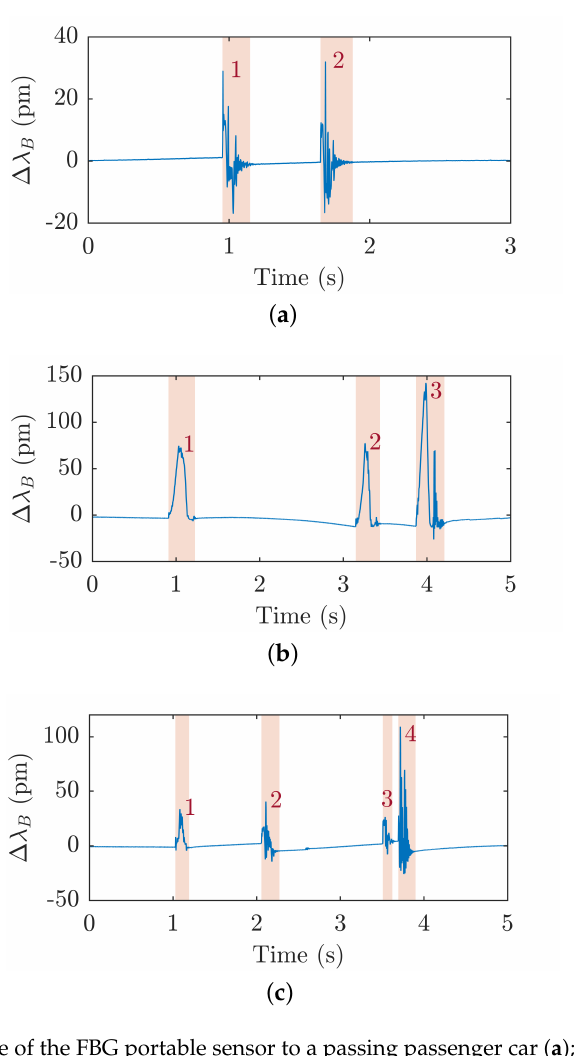
Figure 9. The response of the FBG portable sensor to a passing passenger car ( a ); a passenger car with a two-axle trailer ( b ); and a three-axle truck ( c ).